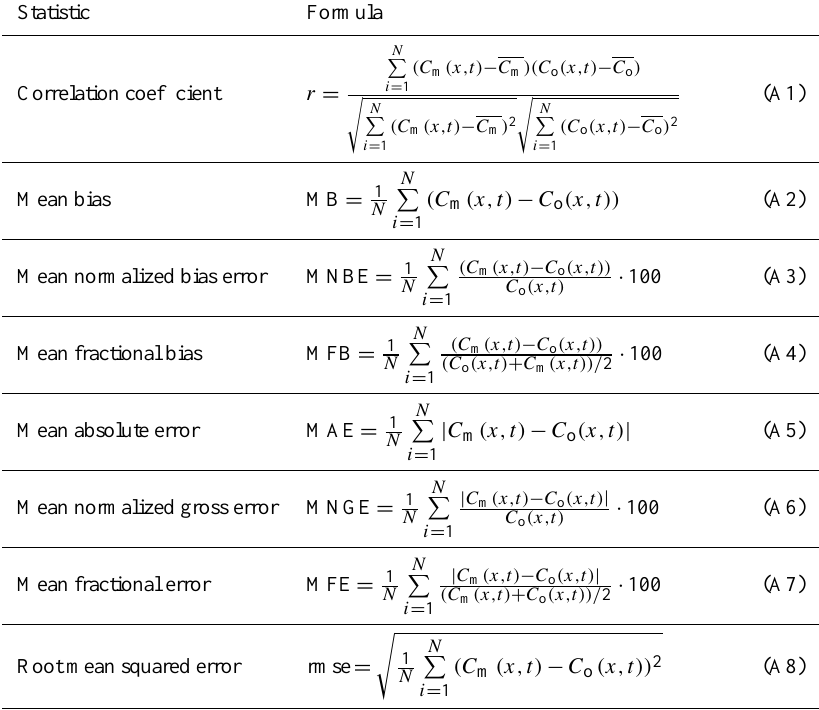
Table A1. Definition of the discrete statistics used in the evaluation, where C m (x,t) and C o (x,t) are the modeled and observed concentrations at a location ( x ) and time ( t ); N is the number of pairs of data. C m and C o are the modeled and observed mean concentrations over the whole period, respectively.